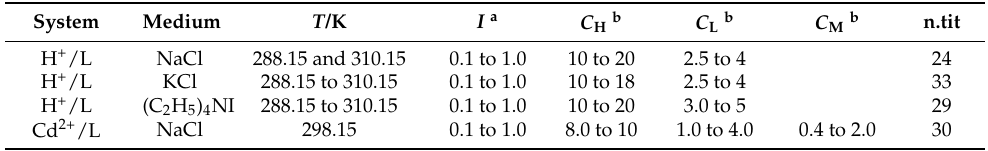
Table 2. Summary of the potentiometric titrations performed (L stands for GLDA) performed in different ionic media at different temperatures, ionic strengths, and p = 0.1